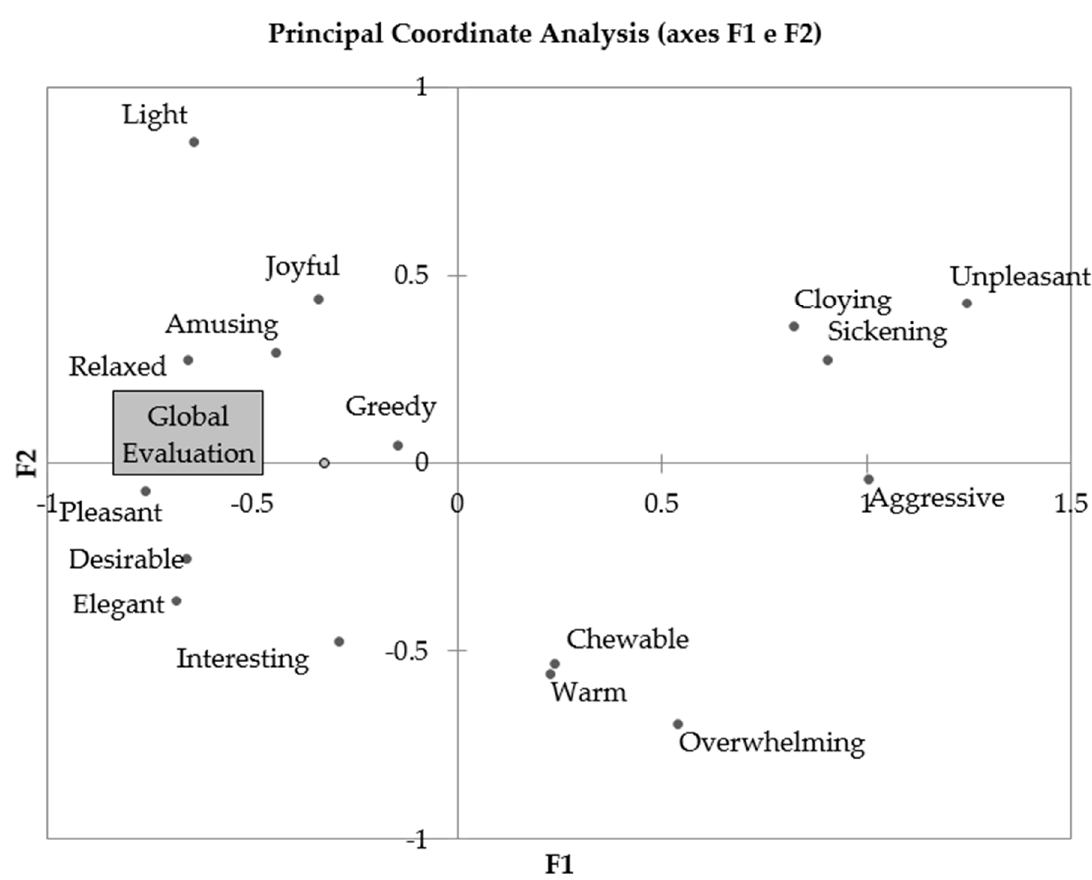
Figure 4. Principal Component Analysis of the results from the CATA evaluation combined with the “global evaluation” scores.